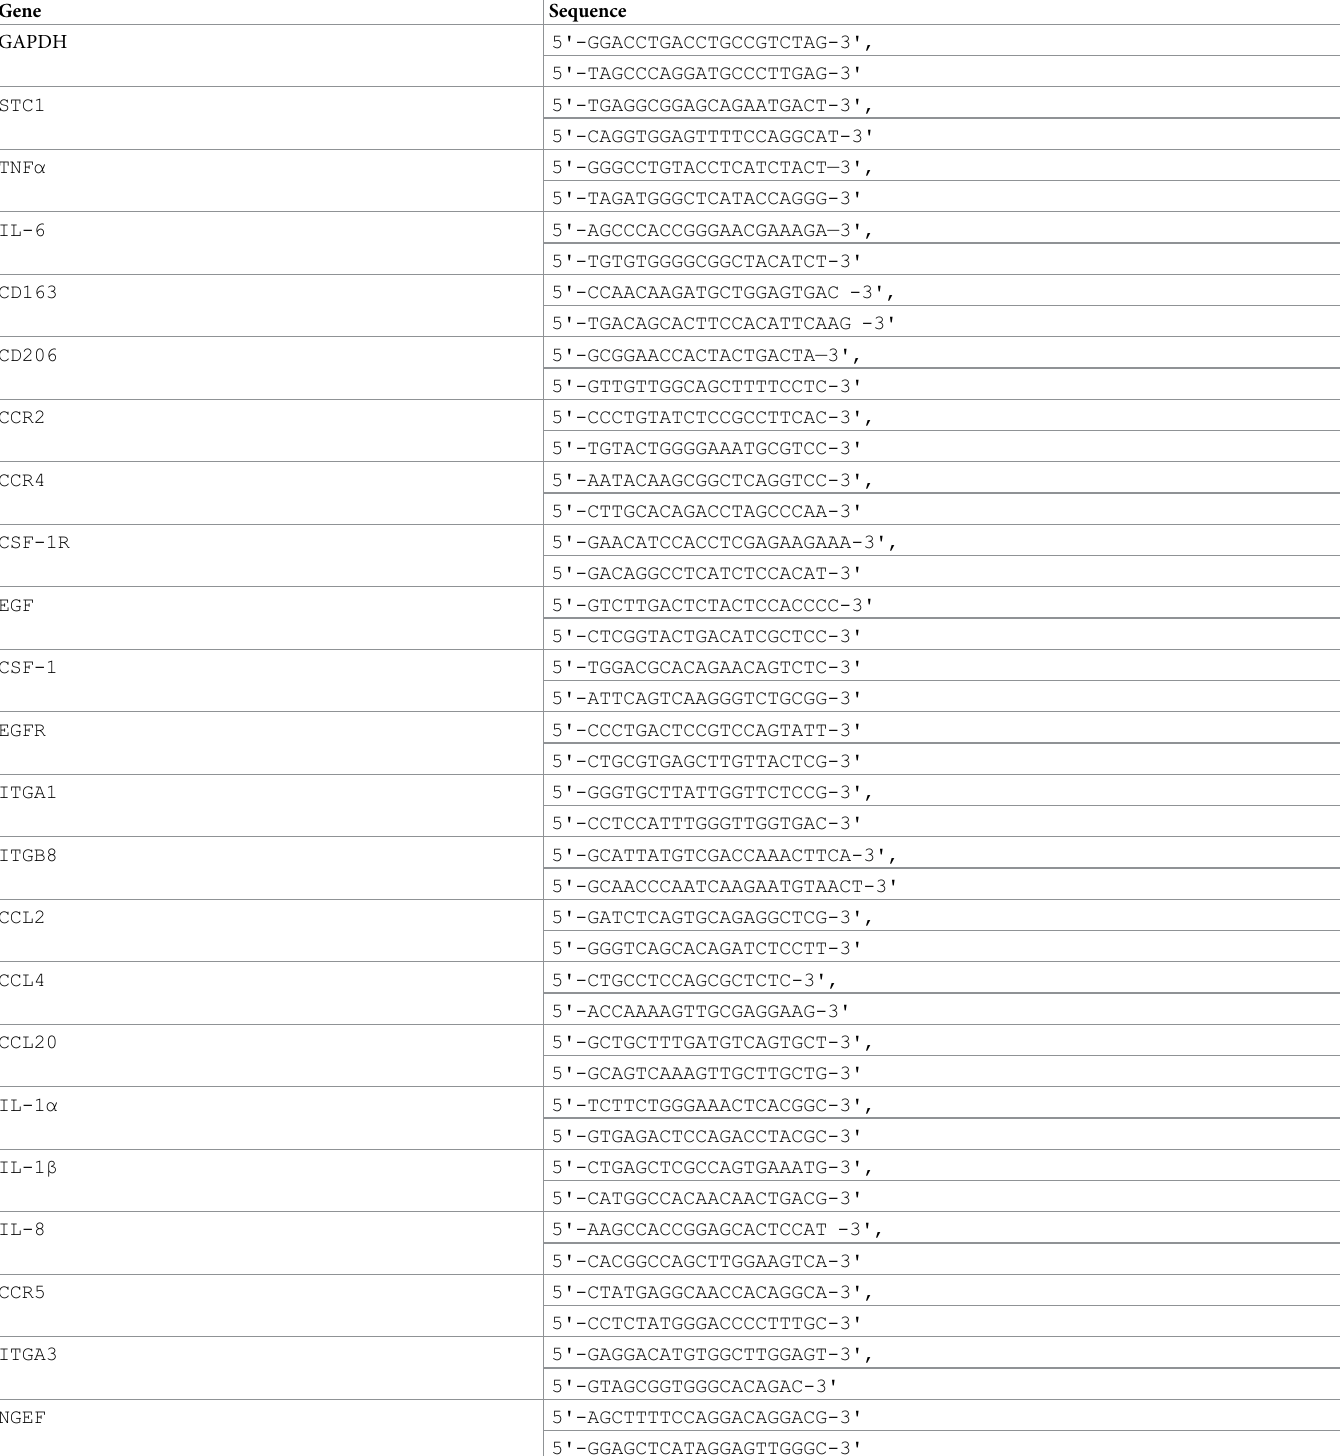
Table 1. List of PCR